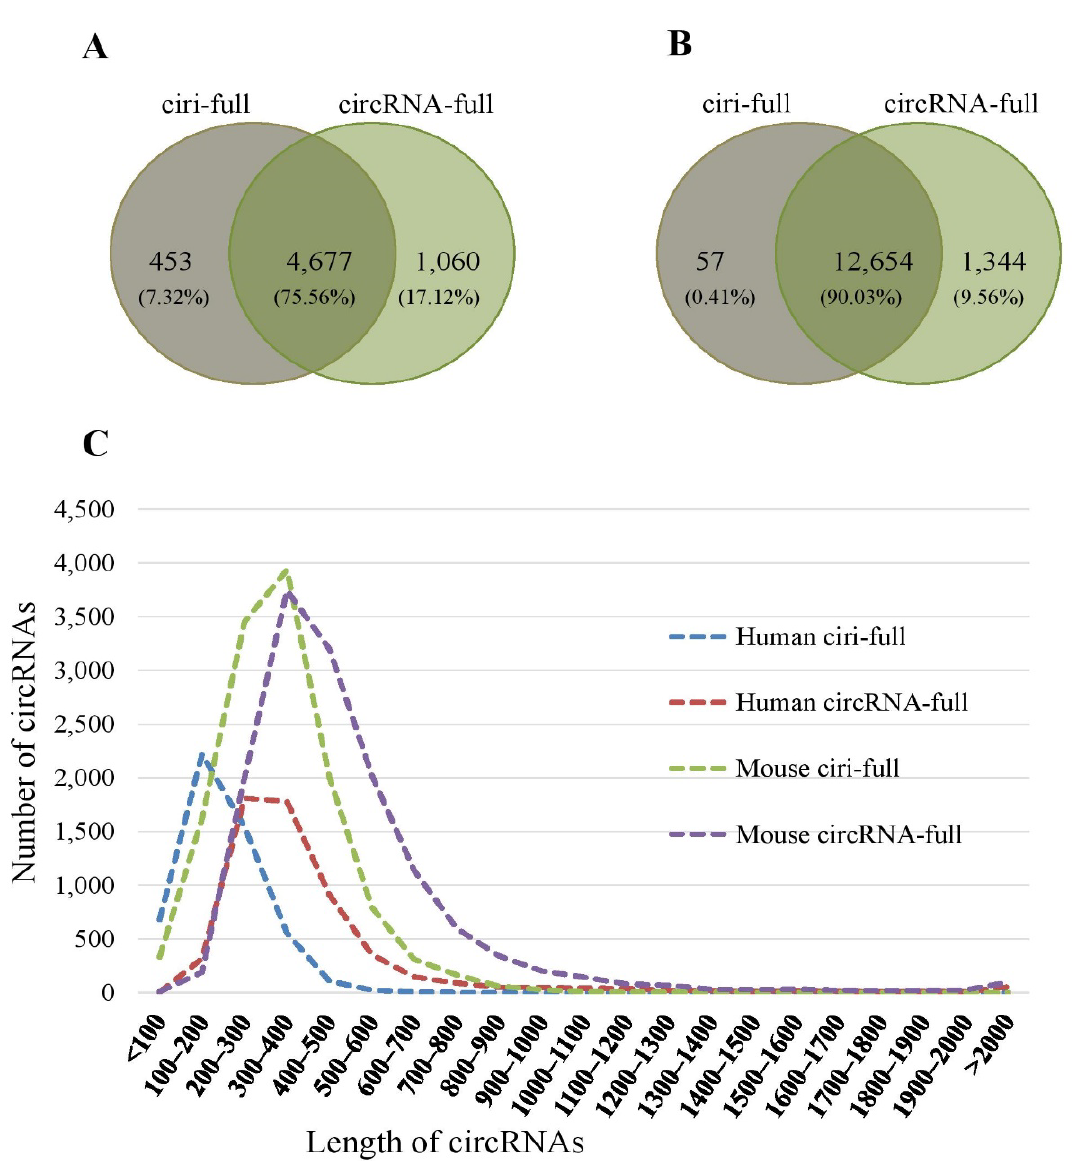
Figure 3. Sequence reconstruction results for circRNA-full and ciri-full. ( A ) Venn-diagram of the number of reconstructed circRNAs for human data. ( B ) Venn-diagram of the number of reconstructed circRNAs for the mouse data. ( C ) Length distribution of reconstructed circRNAs.